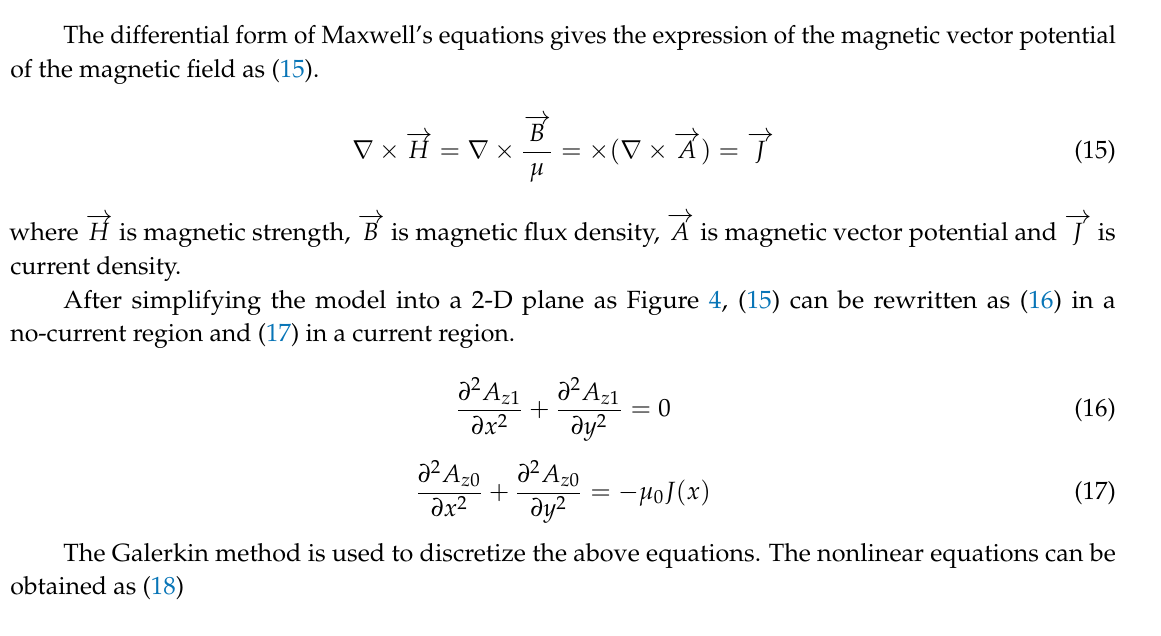
Figure 4. Simplified finite element model of the linear generator.